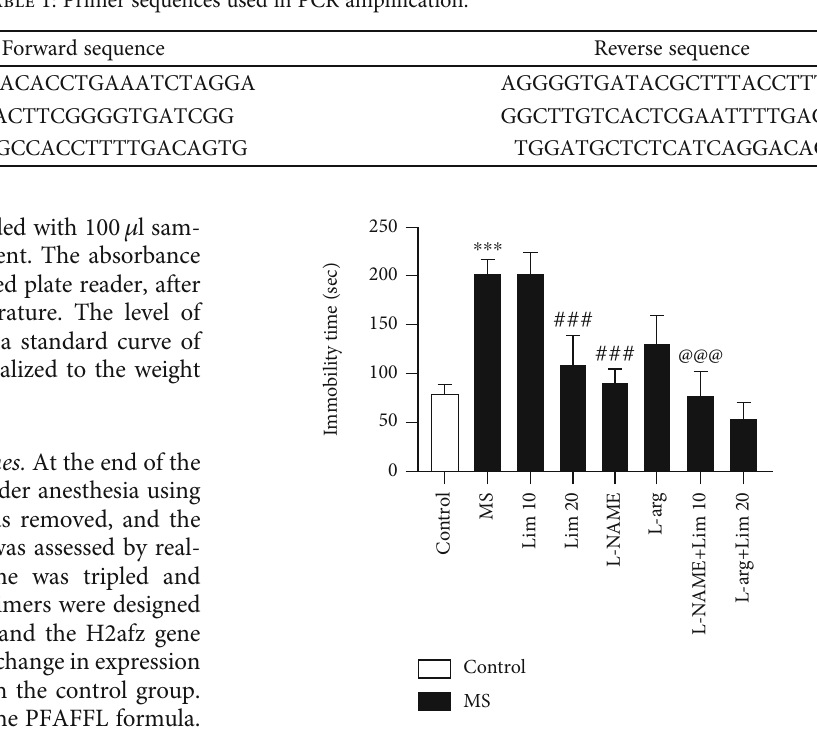
Figure 2: Duration of immobility in the forced swimming